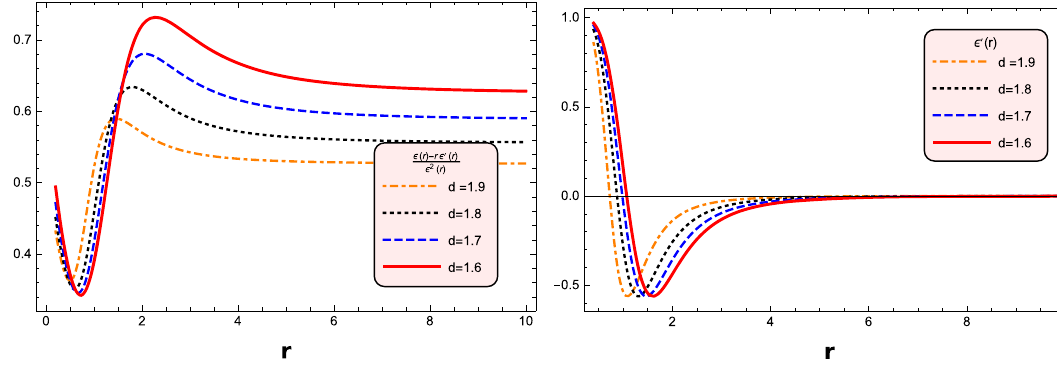
(cid:2) ( r ) > 0 (1st plot) and (cid:3) (cid:2) ( r ) < 1 (2nd plot), for r (cid:3)